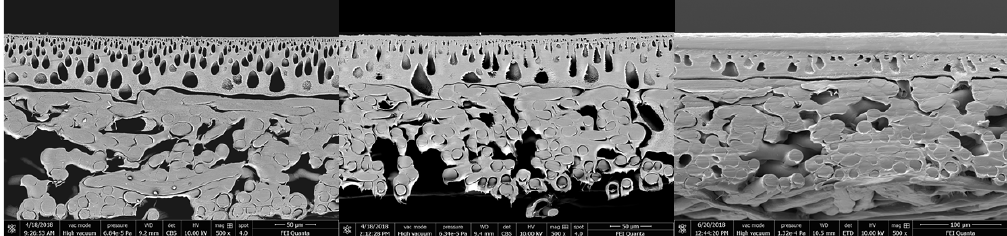
Figure 10. SEM measurement of the whole cross-sections of an unused membrane ( left ), a lowly stressed (max. 25 bar) membrane ( middle ), and a highly stressed (max. 55 bar membrane) ( right